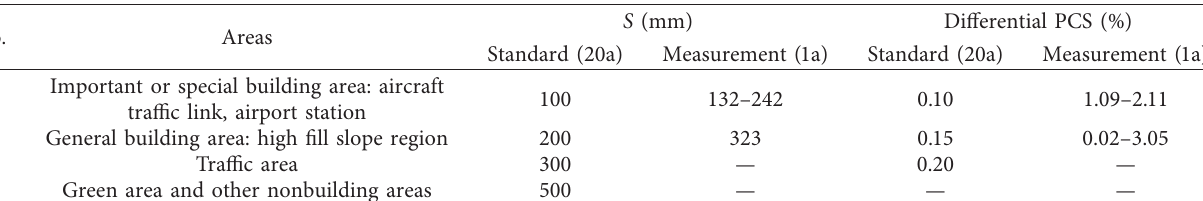
Table 8: Allowable values of crest PCS and differential PCS of HFE in loess ravine.